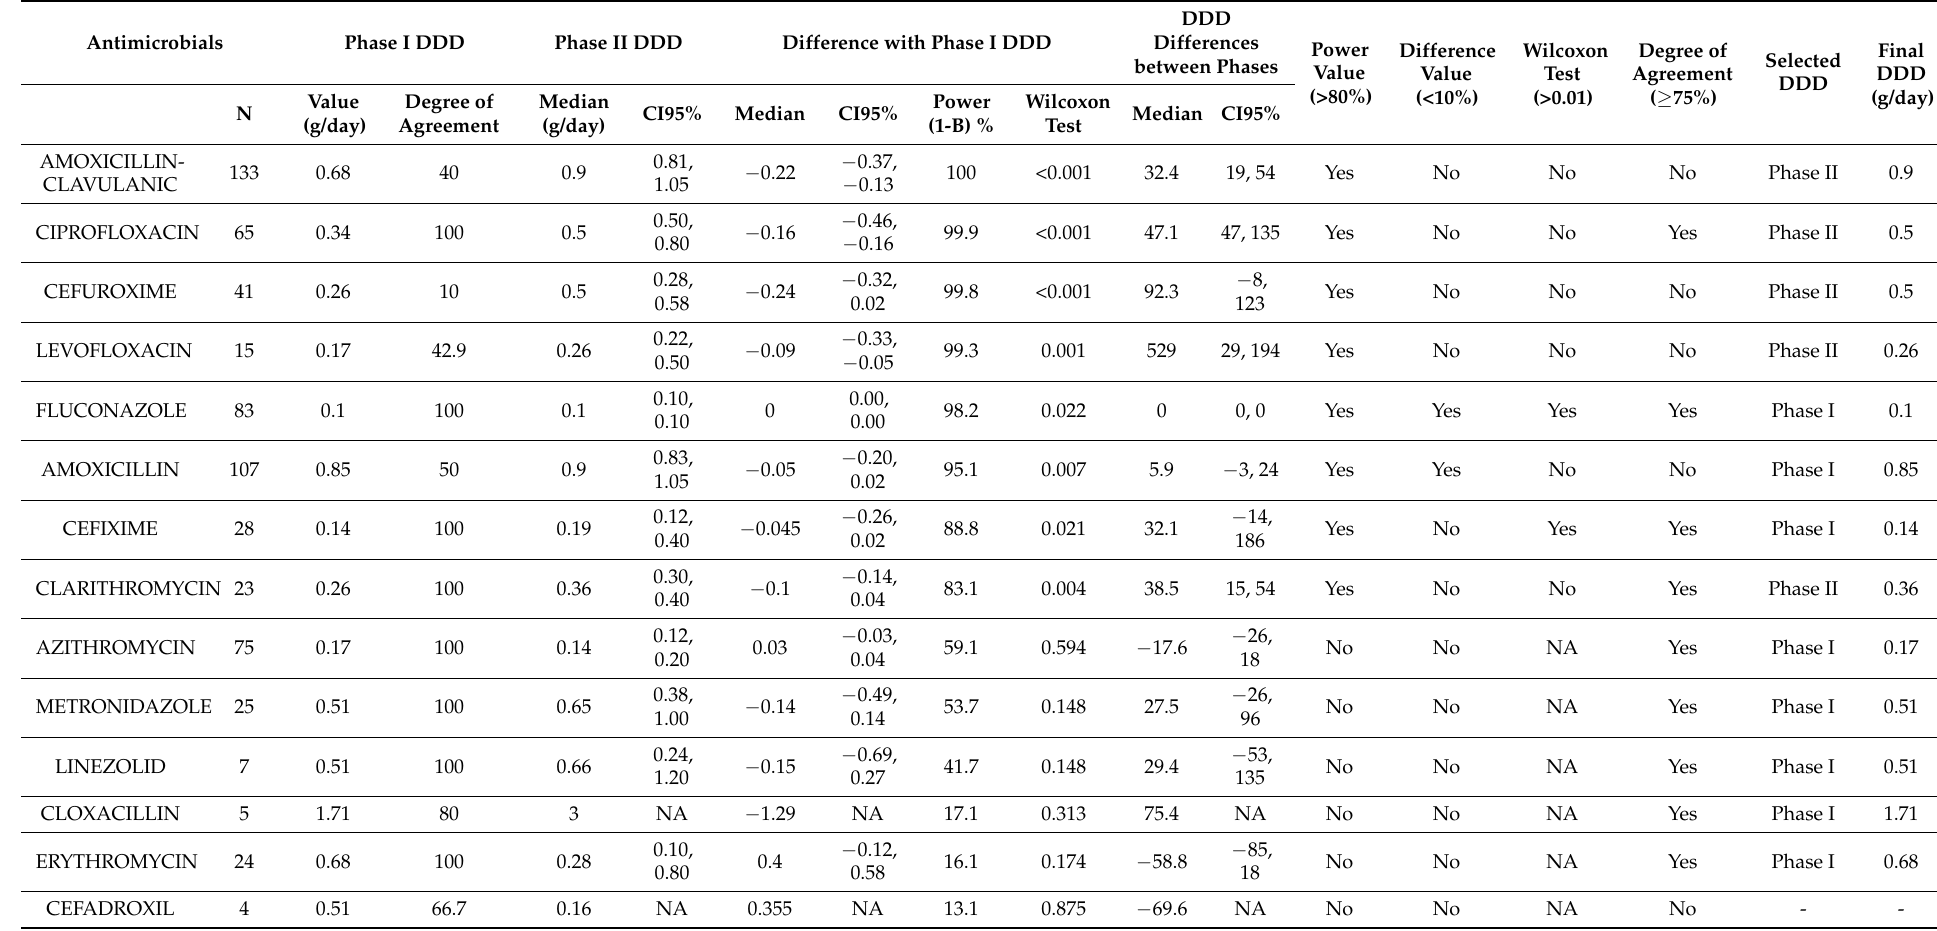
Table 4. Pediatric-defined daily doses of orally administered antimicrobials according to the results of data analysis.